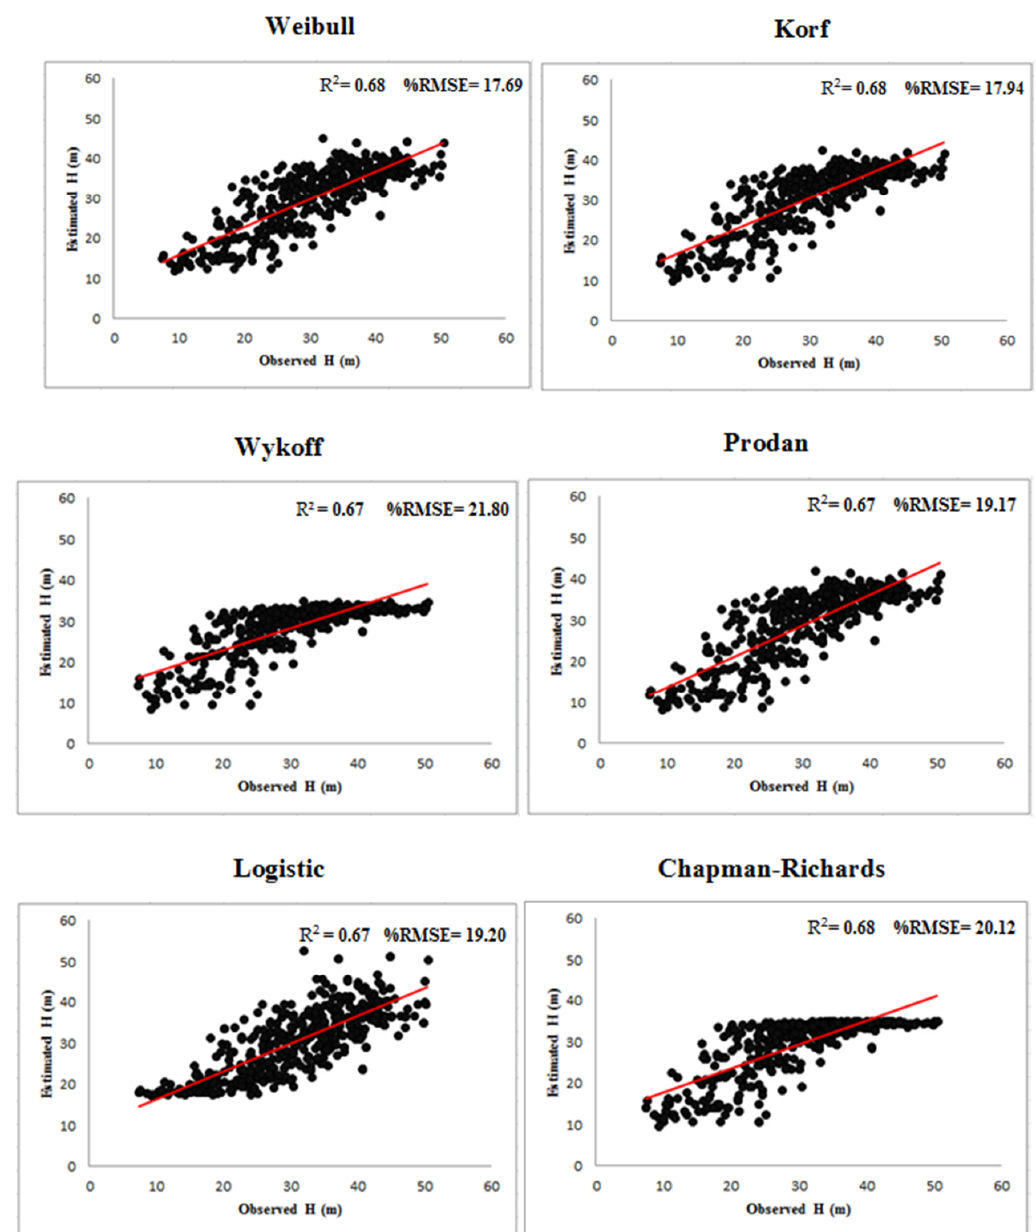
Figure 6. Estimated heights versus observed heights by 10 empirical models (testing R 2 and RMSE (%)